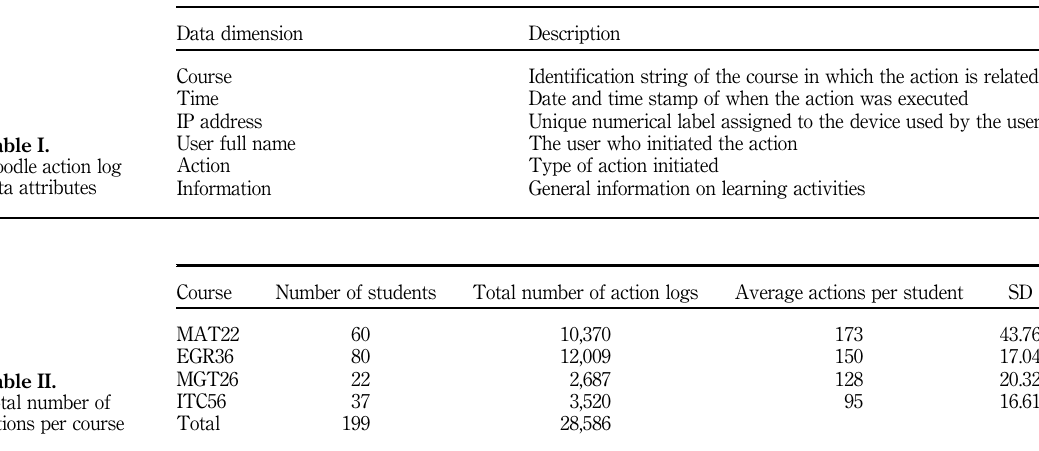
Table II. Total number of actions per